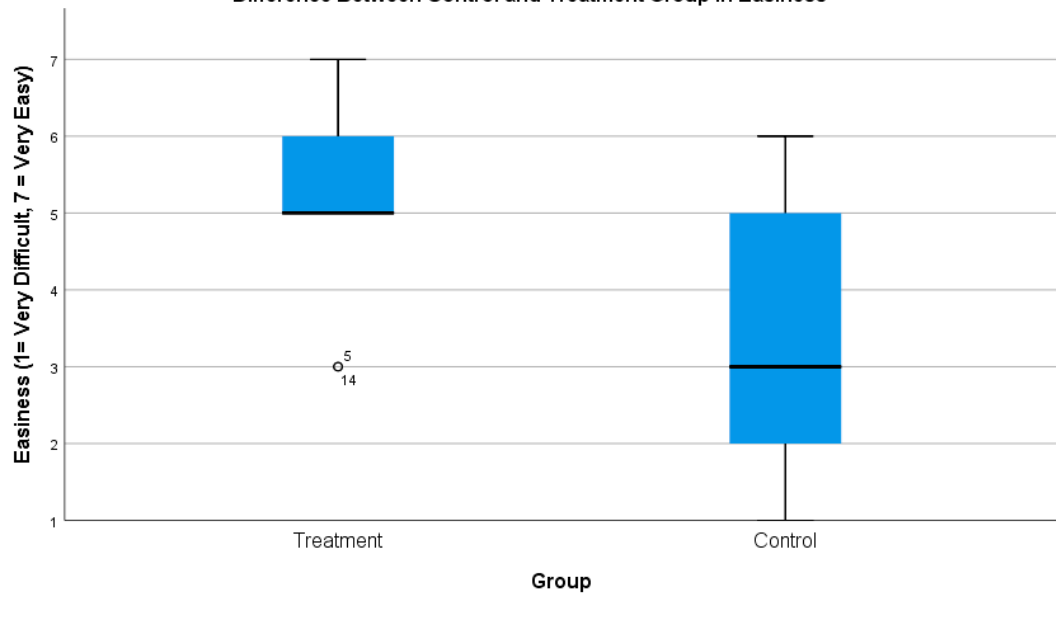
Figure 4. Box plot of easiness.